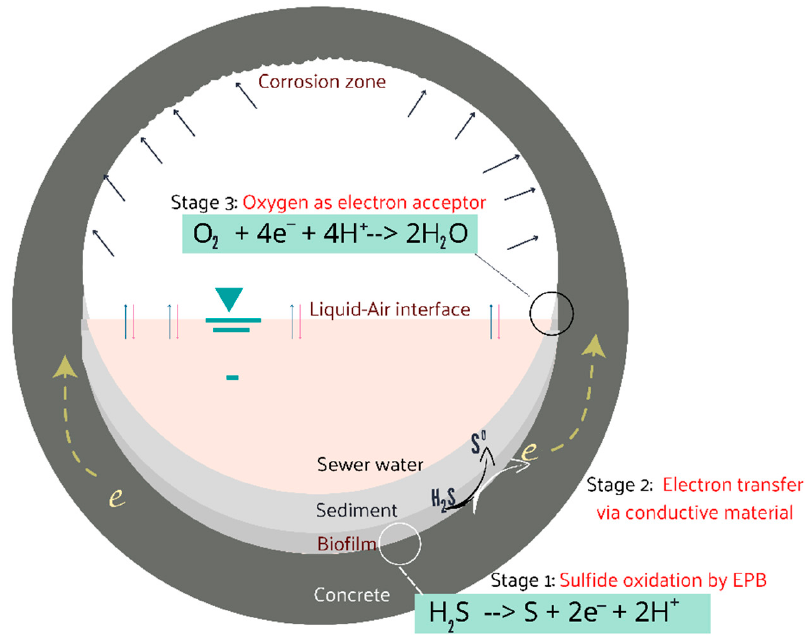
Figure 1. Mechanism of the sulfide oxidation by the electron-emitting bacteria.